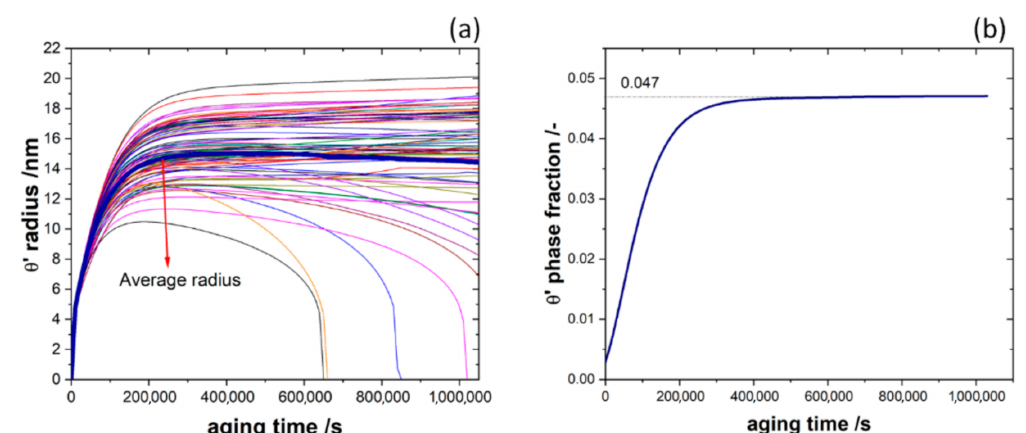
Figure 14. ( a ) Equivalent precipitate radius vs. time for 82 precipitates simulation in Al-1.69 at.% Cu alloy annealed at 453 K for 480,000 s; ( b ) temporal evolution of the precipitates’ phase fraction. The colored lines associate with the individual θ (cid:48) precipitates in the simulation box.